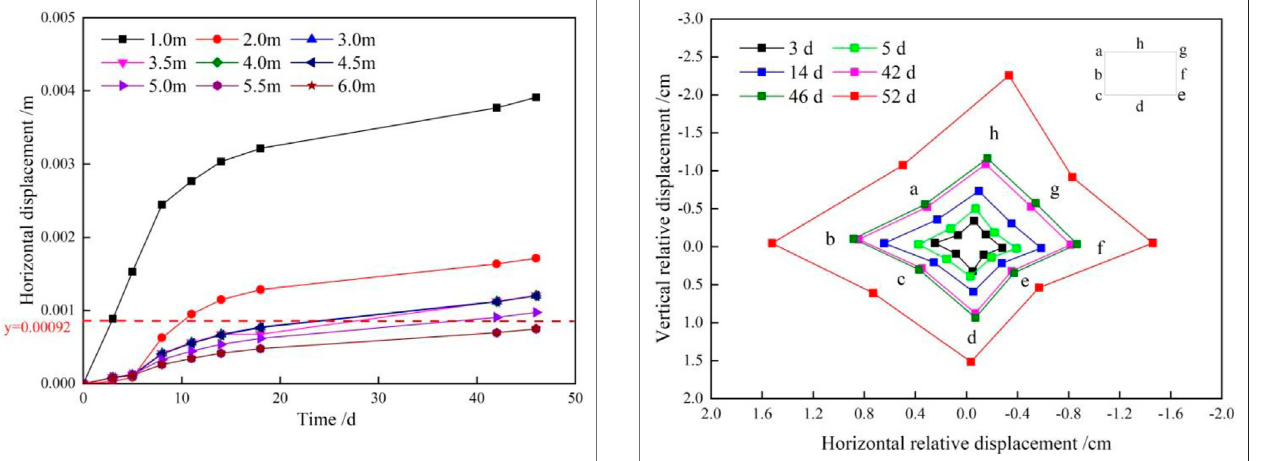
FIGURE 10 | Relationship between horizontal displacement and time at different depths of the surrounding rocks on the left side of roadway. FIGURE 11 | Relative displacement of a roadway section at different